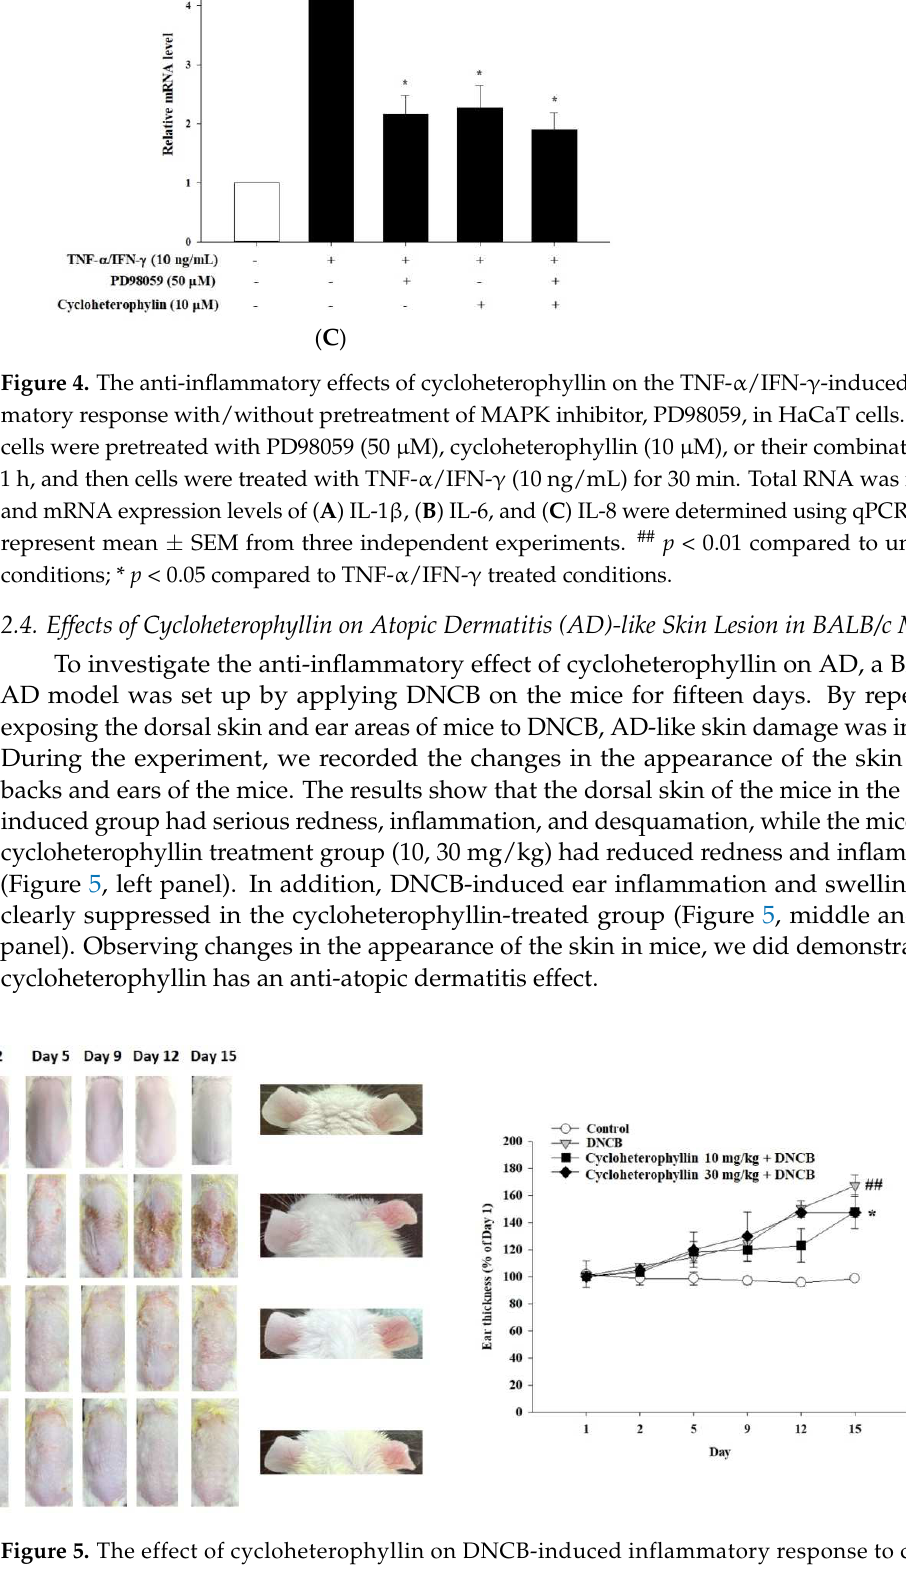
Figure 5. The effect of cycloheterophyllin on DNCB-induced inflammatory response to changes in skin appearance in mice. ( Left panel) shows the effect of the skin changes on the dorsal